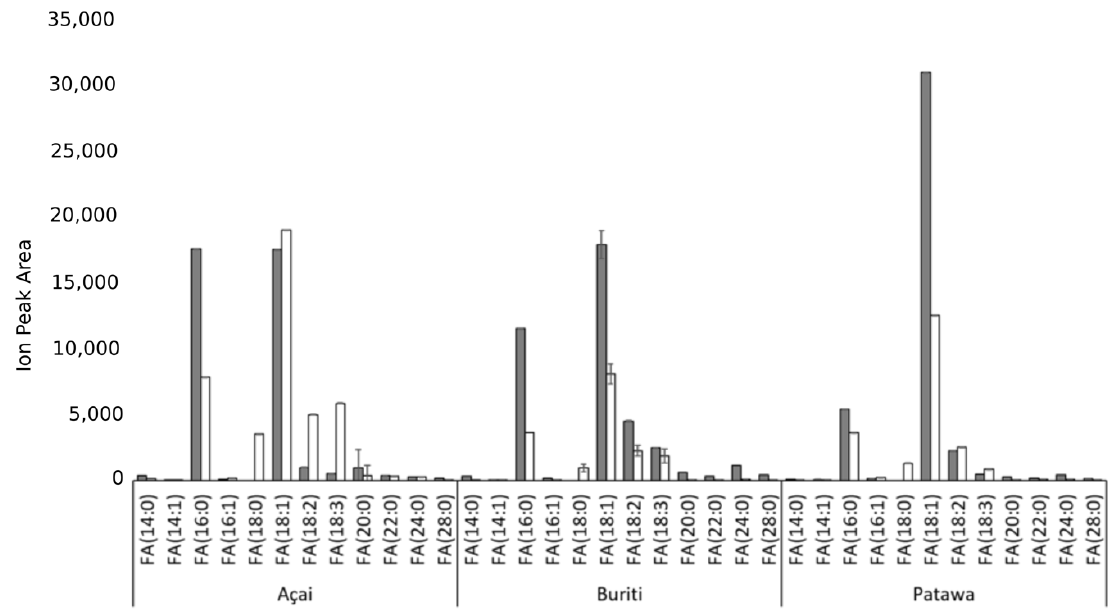
Figure 2. Comparison of fatty acid (FA) content according to extraction method (mechanical extraction — grey bars; solven — white bars) for açai, buriti, and patawa oils.